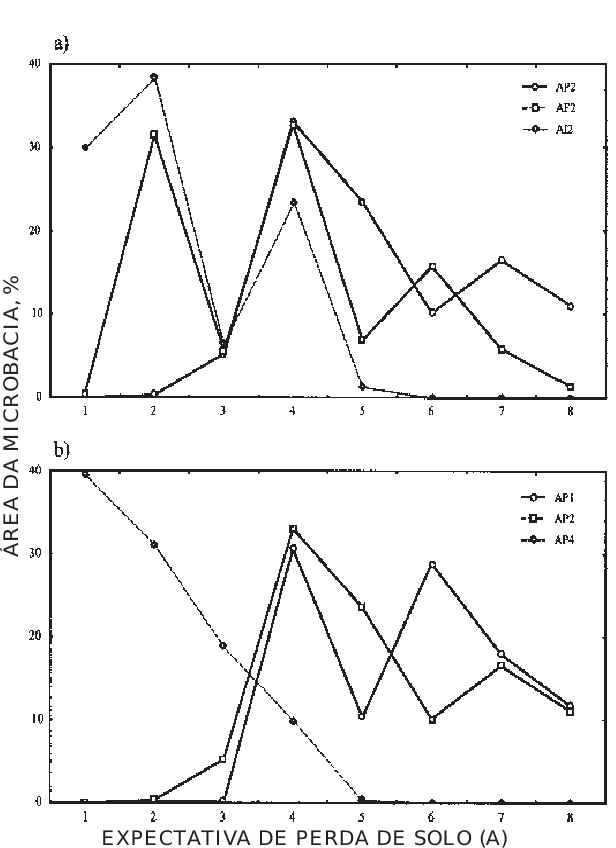
Figura 2. Participação relativa das classes de expectativa de perda de solo segundo variação dos valores do fator C (cobertura e manejo), sob condições extremas de potencial natural de